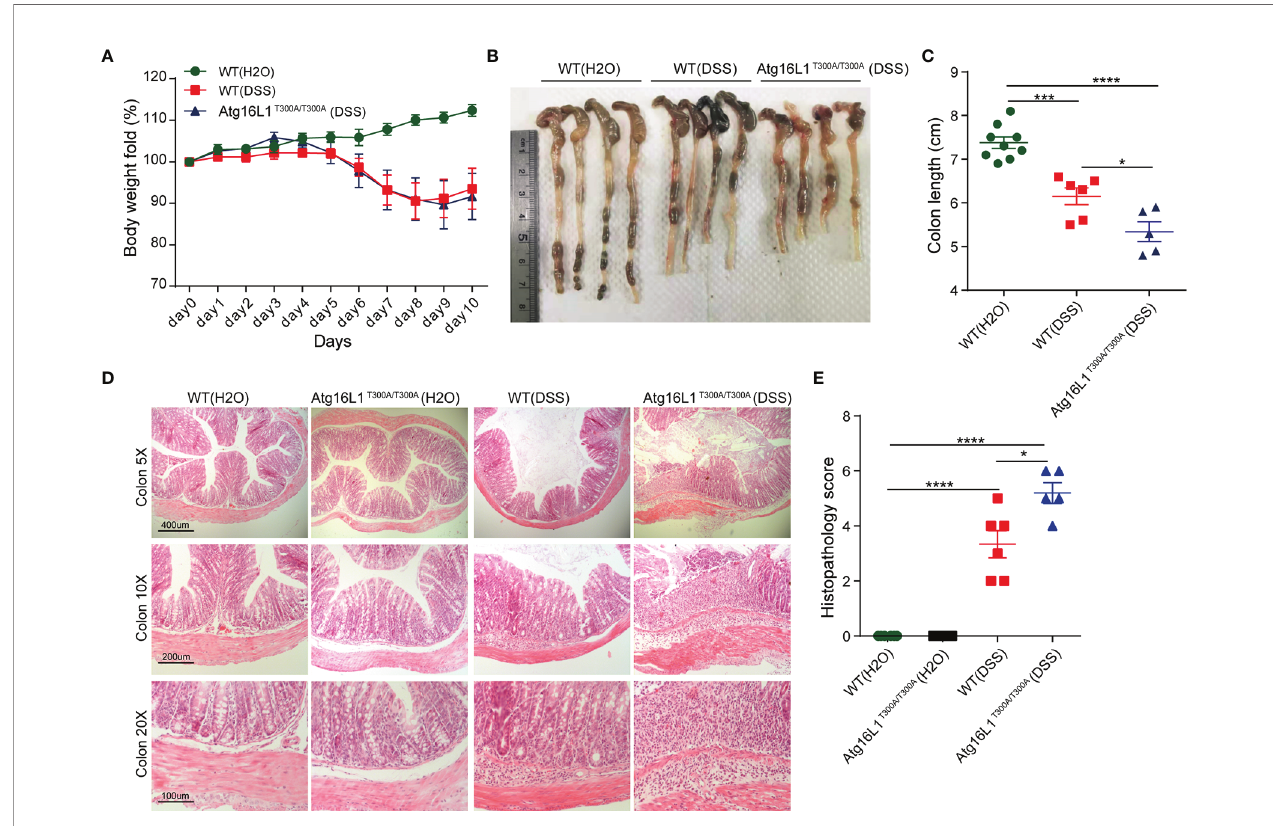
FIGURE 5 | Atg16L1 T300A/T300A mice exhibit more severe in fl ammation in DSS-induced colitis. (A) Weight loss of WT mice with drinking water (n = 9, 3 male and 6 female) and cohoused WT (n = 6, 2 male and 4 female) and Atg16L1 T300A/T300A mice (n = 5, 1 male and 4 female) treated with 1.5% DSS for 7 days followed by 3 days of regular drinking water. (B, C) Gross pathology of colons on day 10 post 1.5% DSS. (D) Representative H&E staining of distal colon sections obtained from cohoused WT and Atg16L1 T300A/T300A mice with drinking water and cohoused WT and Atg16L1 T300A/T300A mice on day 10 post DSS treatment (scale bar, represents 400 m m; images acquired at 5×; represents 200 m m; images acquired at 10×; represents 100 m m; images acquired at 20×). (E) Histological analysis of distal colon harvested at day 10 post-DSS provided by a pathologist blinded to the groups and the study. Results representative of at least 3 independently performed experiments and displayed as mean ± SEM. *p < 0.05; ***p < 0.001; ****p < 0.0001 (non-parametric test followed by a Mann – Whitney test; one/two-way ANOVA analysis followed by a Tukey/Bonferroni post hoc test for three group